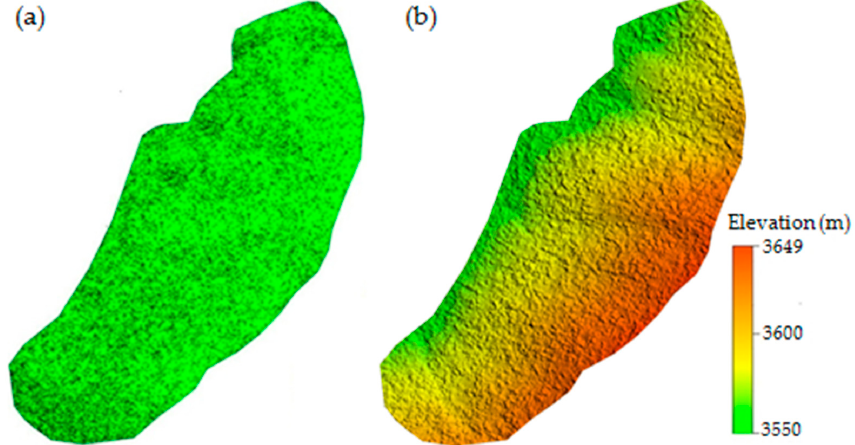
Figure 7. Three-dimensional (3D) point cloud of the test site acquired by Aerial Triangulation (AT) method, and the rasterized Digital Elevation Model (DEM).